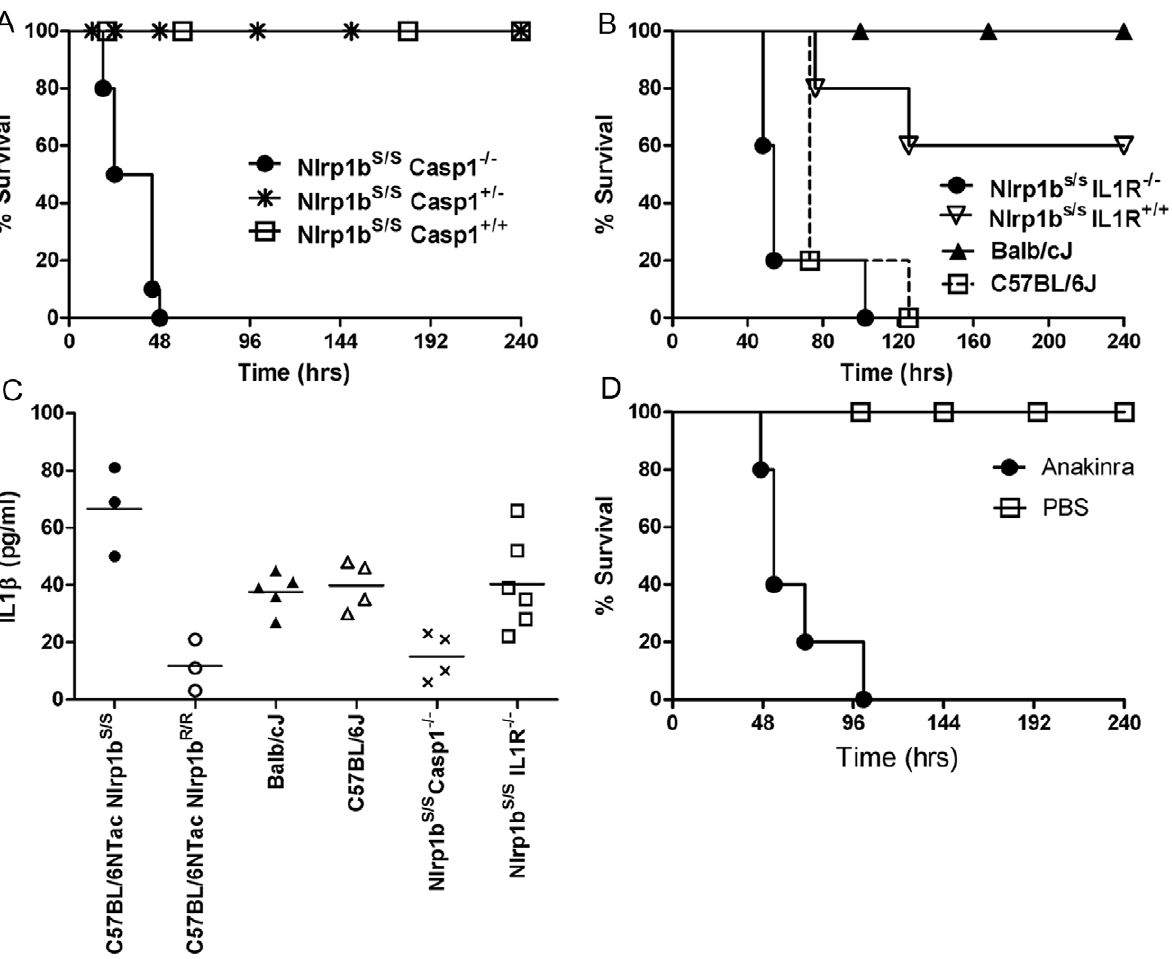
Figure 5. Nlrp1b S -mediated resistance to infection requires caspase-1 and IL-1 b . (A) Nlrp1b S/S Casp1 2 / 2 , Nlrp1b S/S Casp1 + / 2 , and Nlrp1b S/S Casp1 + / + mice (Balb/cJ background, N4), were infected with 2 6 10 7 spores (SC) and monitored for survival. Numbers per group were as follows: Nlrp1b S/S Casp1 2 / 2 (n=10), Nlrp1b S/S Casp1 + / 2 (n=20), Nlrp1b S/S Casp1 + / + (n=6)). P-values for the comparison of the Nlrp1b S/S Casp1 2 / 2 to the three others strains are , 0.0001. (B) Sensitivity of IL-1 receptor knockout mice ( Nlrp1b S/S IL1R 2 / 2 ) was compared to Nlrp1b S/S IL1R + / + (=B6129SF2/ J), Balb/cJ, and C57BL/6J mice (n=5/group) following challenge with 2 6 10 7 spores (SC). Curve comparisons: Nlrp1b S/S IL1R 2 / 2 vs. Nlrp1b S/S IL1R + / + (P=0.0071); Nlrp1b S/S IL1R 2 / 2 vs. Balb/cJ (P=0.0024). (C) Mice were infected with 5 6 10 7 spores (SC) and IL-1 b assessed in serum 6 h after infection. Each data point represents an individual mouse. P-value comparing C57BL/6NTac Nlrp1b S/S and C57BL/6NTac Nlrp1b R/R groups is 0.0062. P-value comparing Balb/cJ and C57BL/6J groups is 0.68. P-values comparing the Nlrp1b S/S Casp1 2 / 2 to any other group except C57BL/6NTac Nlrp1b R/R are , 0.03. (D) Balb/cJ mice (n=5/group) were injected with 50 mg anakinra (IP) or PBS 1 h prior to spore infection, as well as 2, 6, 24, and 32 h post infection. Infection was with 6 6 10 7 spores (SC). P-value comparing the two curves is 0.0022.